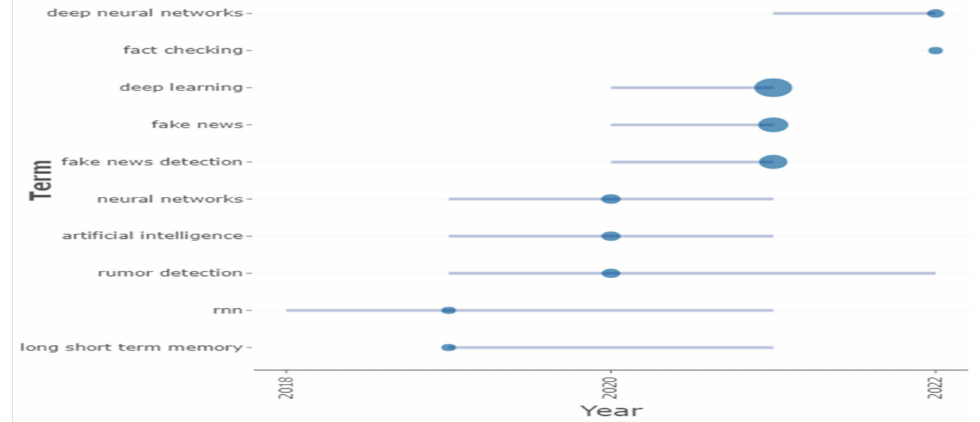
Figure 16. Trend